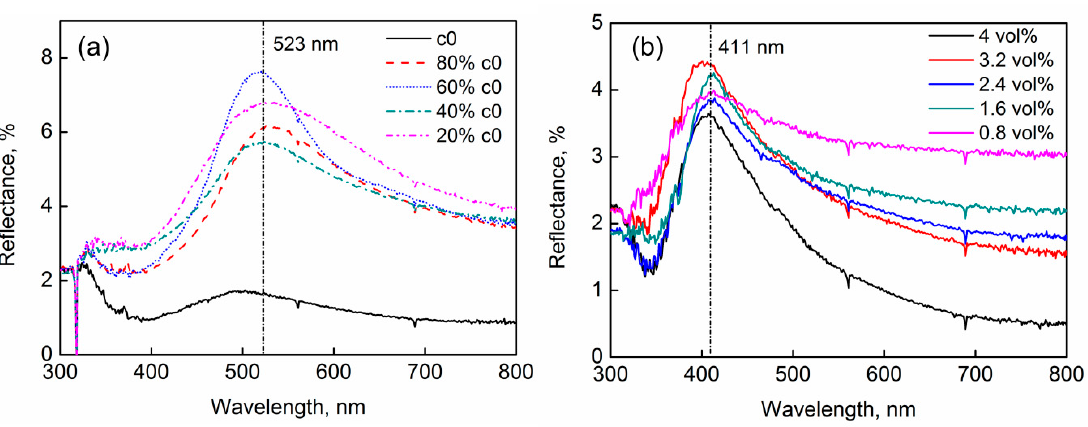
Figure 5. Reflection spectra of the colloidal crystal films prepared from: ( a ) SiO 2 particle (diameter 240 nm)/water latex with different volume fractions of particles; and ( b ) PS particle (diameter 204 nm)/water latex with different volume fractions of particle. The incident angles were 15° in measurements.